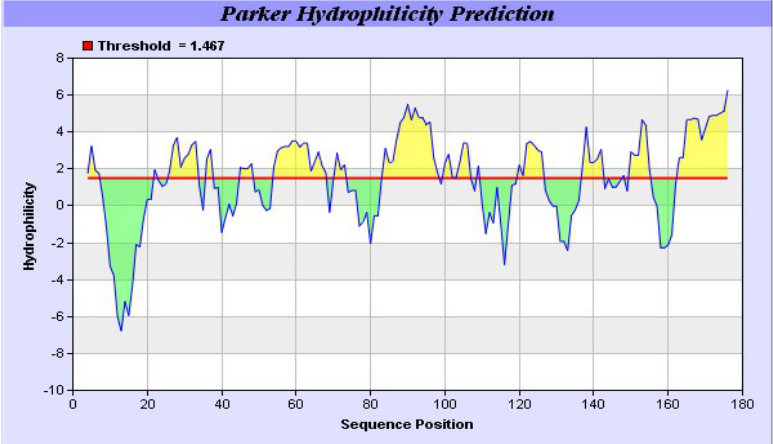
Figure 10. Predicted hydrophobic regions of yak IGF2. The hydrophobic residues forming the binding interface were directed under the threshold value and represented by the residues L32, L37, V38, V44, I59, I67 and LALL (77–80). Transmembrane residues were directed under the threshold line and represented as SVLVLLAFLAFASCCYAA (8–25).